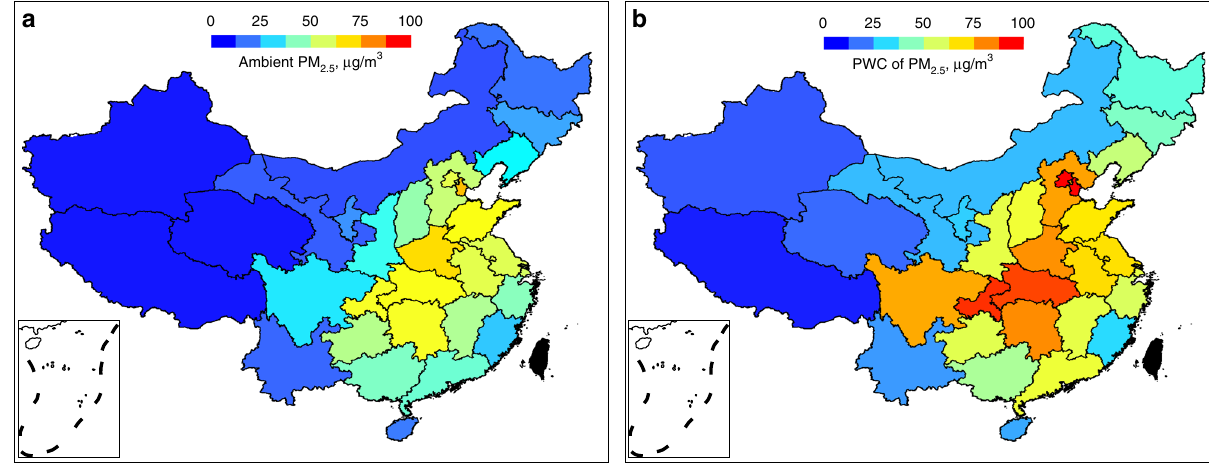
Fig. 2 Spatial distribution of rural residential emission contributions in 2012 in mainland China. Results are shown as absolute contributions to provincial mean air quality concentrations a and population-weighted PM 2.5 concentrations b . Source data are provided as a Source Data fi